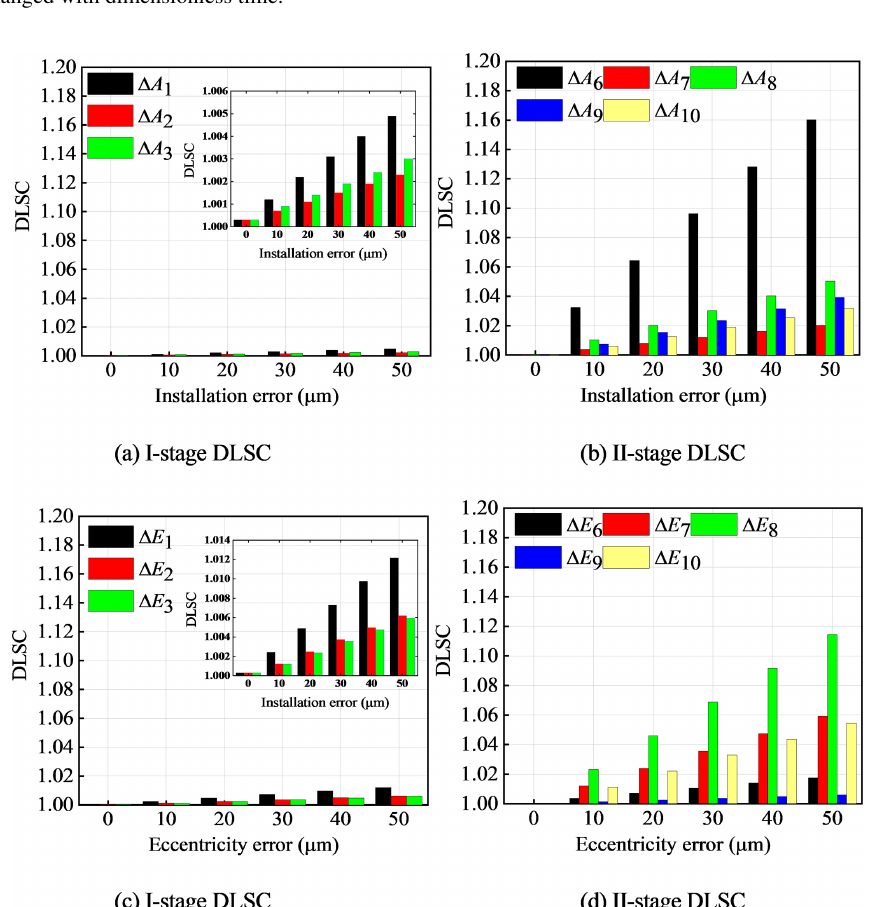
Figure 12. DLSC changed with installation and eccentricity error.